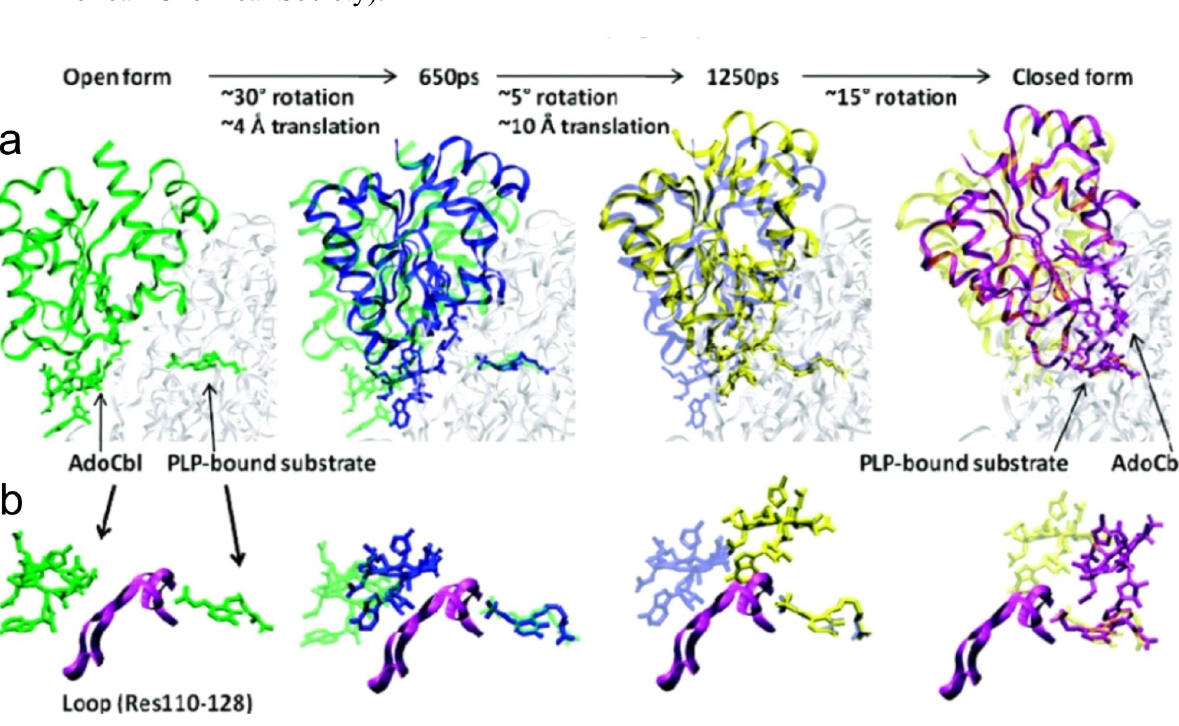
Figure 5. Atomic description of the conformational rearrangement of the Rossmann domain. ( a ) Snapshots along the trajectory 1 (with the targeted molecular dynamics (TMD) simulation time labeled) are selected to highlight the rotational and translational movement; and ( b ) Close-up of the cobalamin ring and PLP-bound substrate within each snapshot in top. The loop formed by residues 110–128 that “gates” the active-site cavity is displayed in purple ribbon (Adapted with permission from reference [64]. Copyright 2012 American Chemical